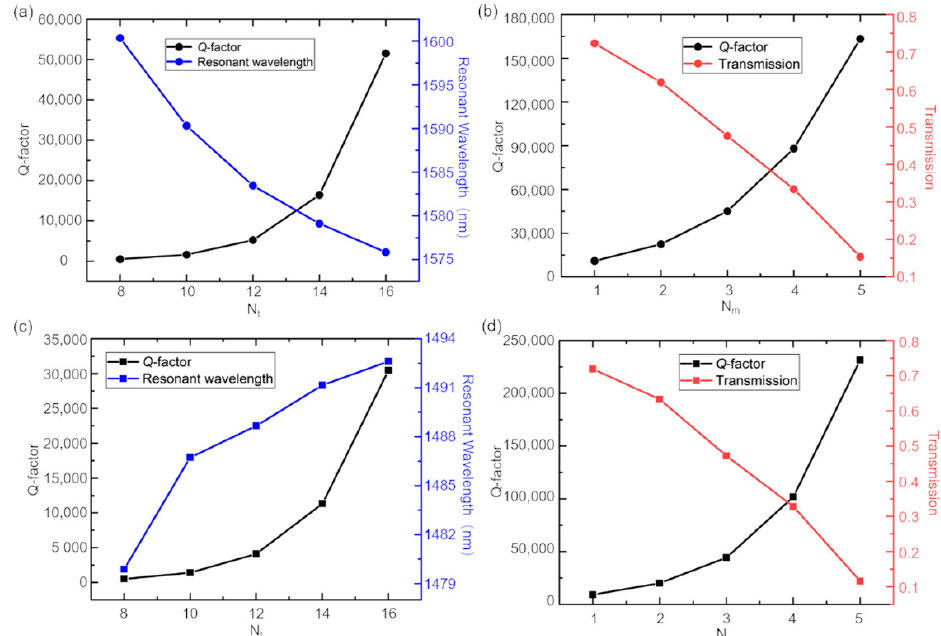
Figure 4. The dependence of the Q ‐ factor and resonant wavelength on the N t obtained by 3D ‐ FDTD simulations ( a ) for cav 1 and ( c ) cav 2 . The relationship between r and transmission on N m obtained by 3D ‐ FDTD simulations ( b ) for cav 1 and ( d ) for cav 2 .